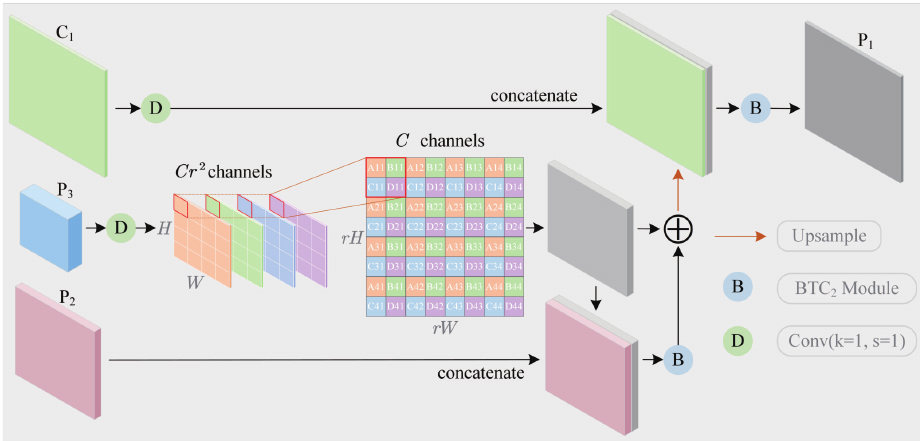
Figure 5. The structure of FMF. The low-resolution feature maps P 2 and P 3 with rich semantic information are mapped to the high-resolution space and fused with the feature map C 1 with rich spatial information to generate a high-resolution feature map P 1 with rich semantic and spatial information. P 2 and P 3 are generated by FPN shown in Figure 4. C 1 is the output feature map in the APSConv